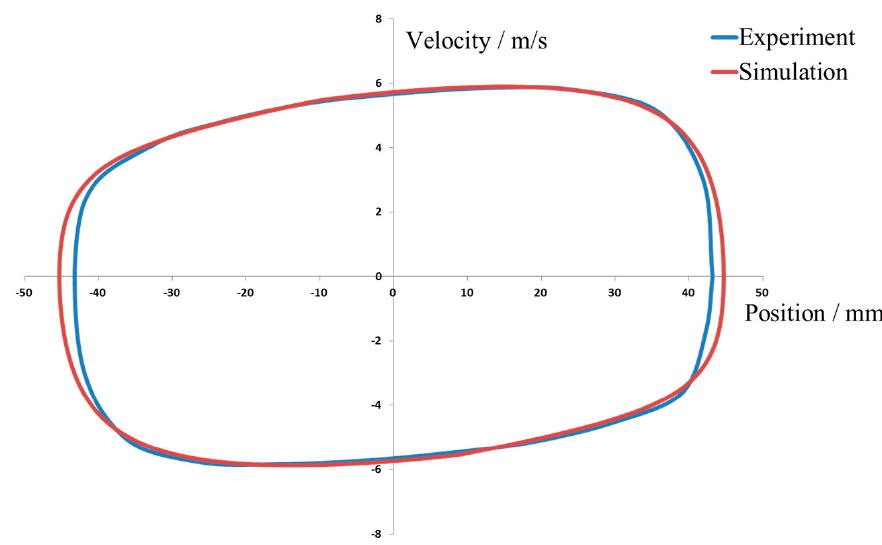
Figure 6. Piston velocity ‐ position traces.